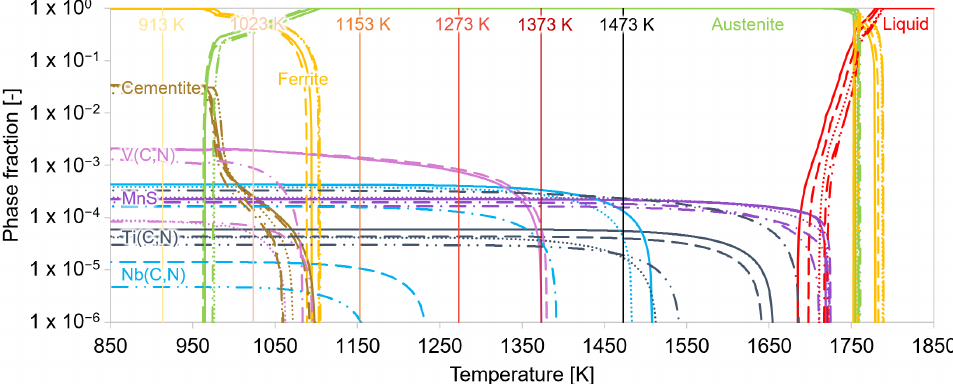
Figure 2. Equilibrium calculations of MA steels S5–S1. The vertical lines indicate the individual de- formation temperatures. deformation